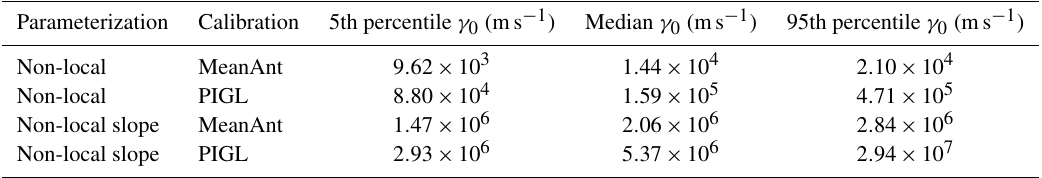
Table 2. Calibrated γ 0 (ms − 1 ) values calculated for the non-local parameterizations in the ISMIP6 protocol in Jourdain et al. (2020) and Lipscomb et al.